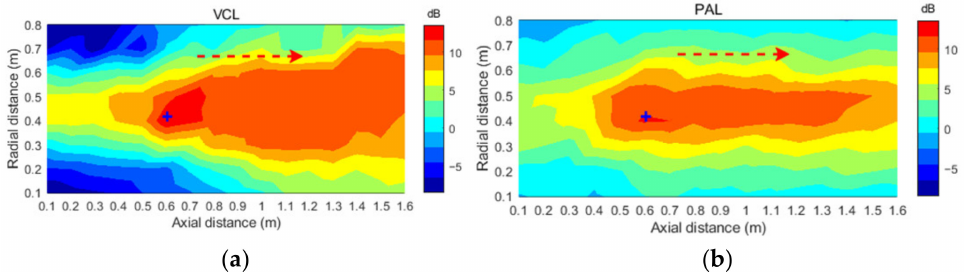
Figure 11. Noise reduction distribution of PAL and traditional VCL. ( a ) VCL; ( b )